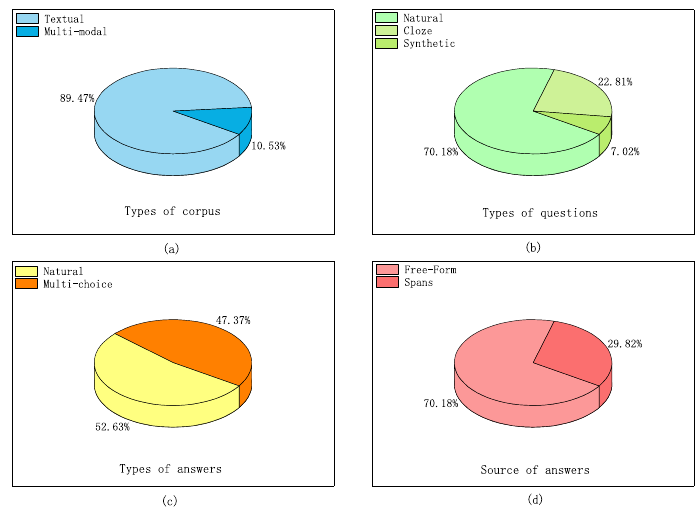
Figure 16. A pie chart on the proportion of different types of machine reading comprehension tasks: ( a ) Type of corpus. ( b ) Type of questions. ( c ) Type of answers. ( d ) Source of